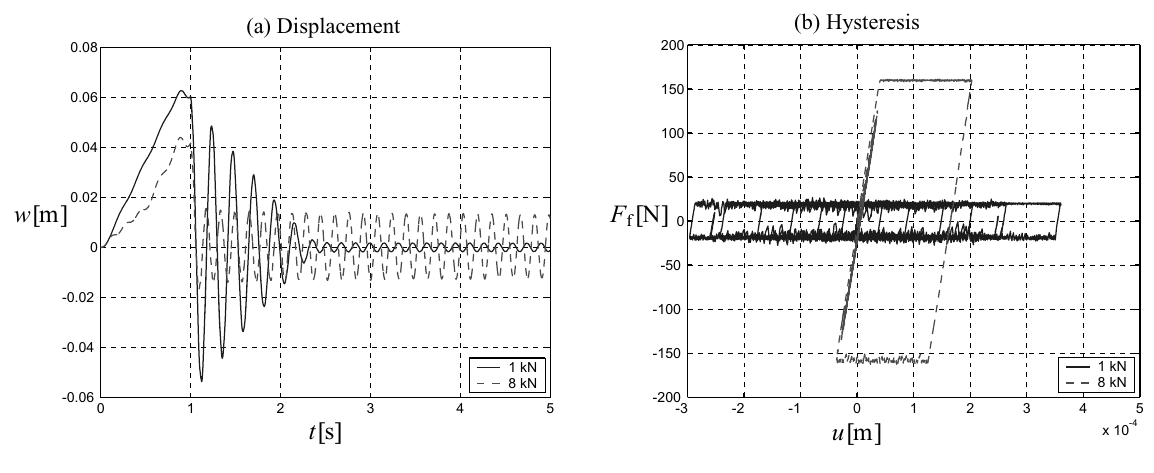
Fig. 3. Comparison of the free vibration and hysteresis for two normal forces (both numerical simulations).